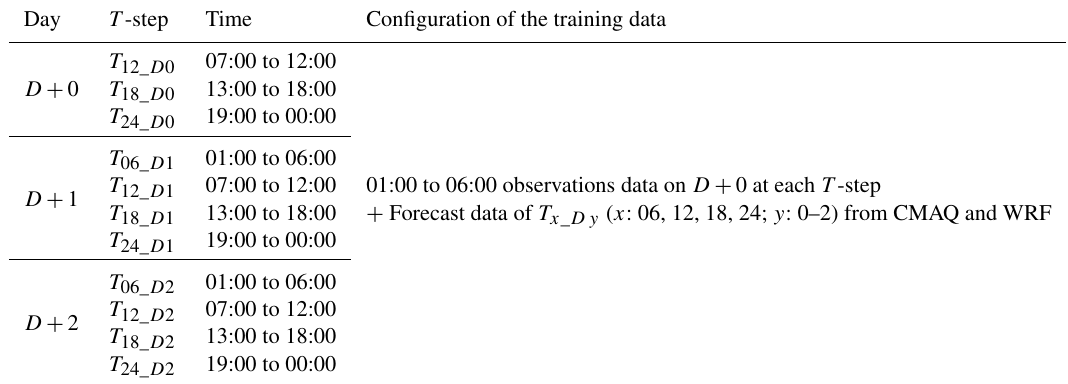
Table 3. Configuration of the training data for each T -step to implement the DNN model for the 6h average prediction.